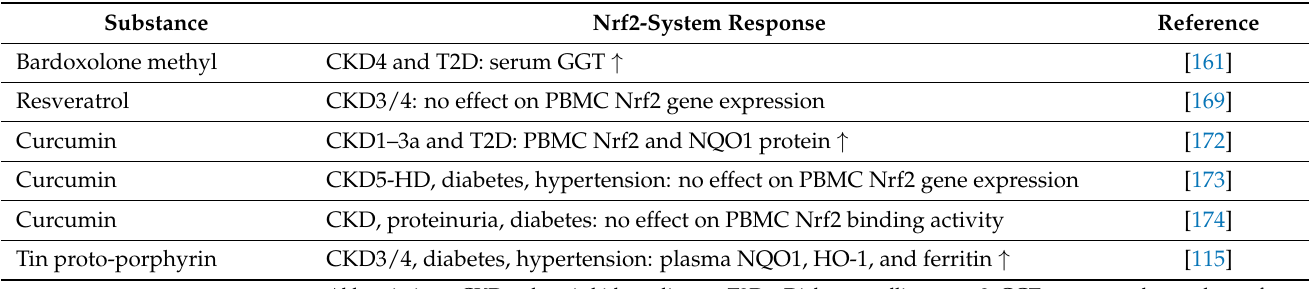
Table 3. Molecular responsiveness of the Nrf2 system to pharmacological Nrf2 activation in human CKD with respect to CKD stage and